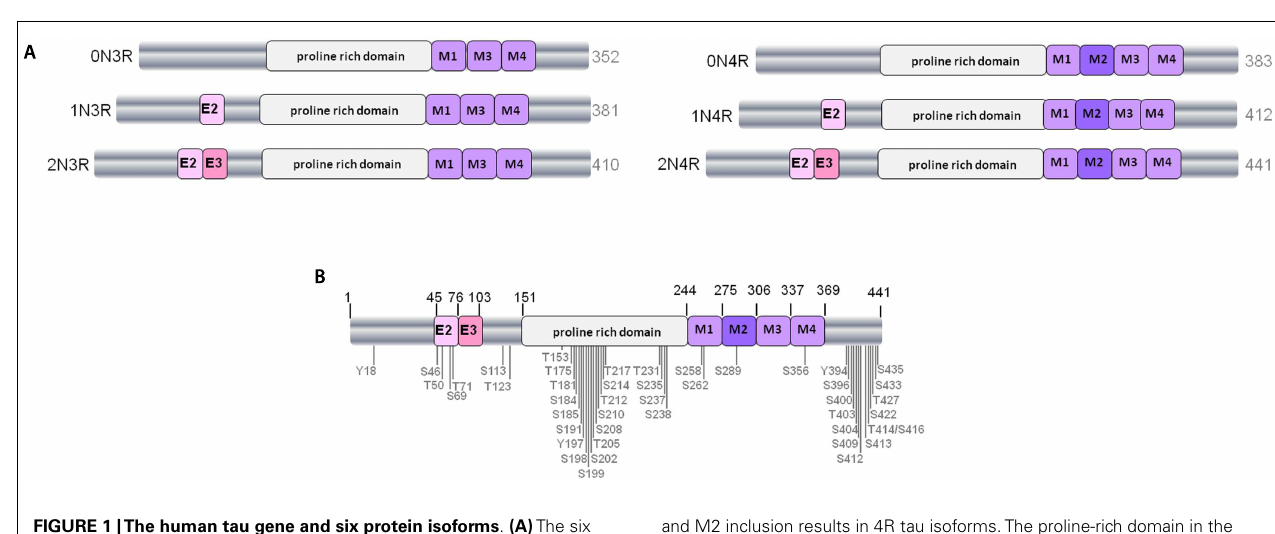
FIGURE 1 |The human tau gene and six protein isoforms . (A) The six isoforms of human CNS tau. Exons 2 and 3 (E2 and E3) encode two different inserts of 28 amino acids near the N-terminus of tau. Absence of E2 and E3 gives rise to 0N tau isoforms, whereas inclusion of E2 produces 1N and inclusion of both E2 and E3 results in 2N tau isoforms. M1–M4 represent the four imperfect-repeat microtubule-binding domains, M2 being encoded by exon 10. Lack of M2 results in the formation of 3R tau